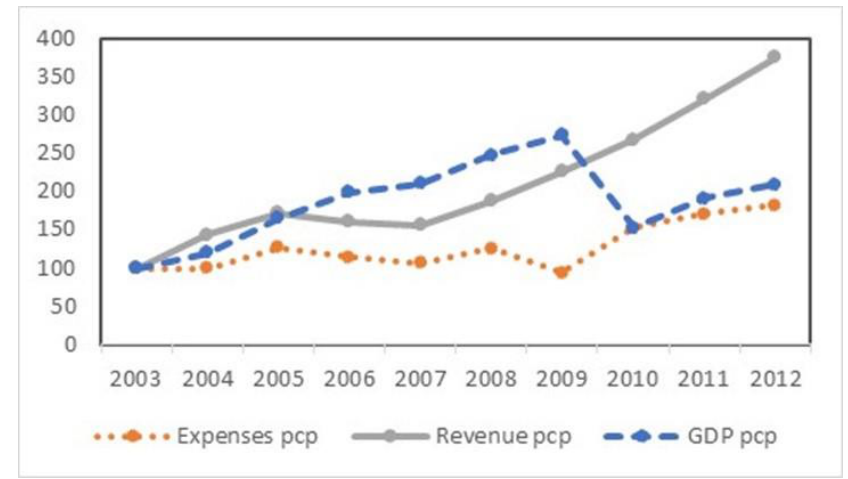
Figure 3. GDP per capita, Revenue per capita and Expenses per capita; base: 2003.